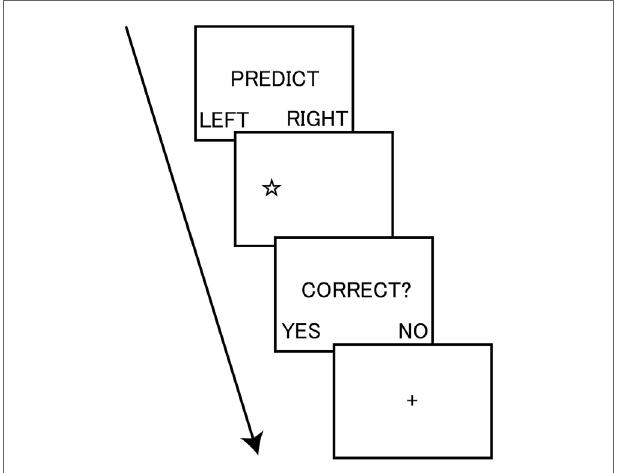
figUre 1 | Task sequence of the incentivized prediction task. The participant privately predicted the location of the upcoming stimulus of a star shape. The participant then observed the outcome of the stimulus location (left or right) and indicated whether the prediction was accurate. The task was self-paced.